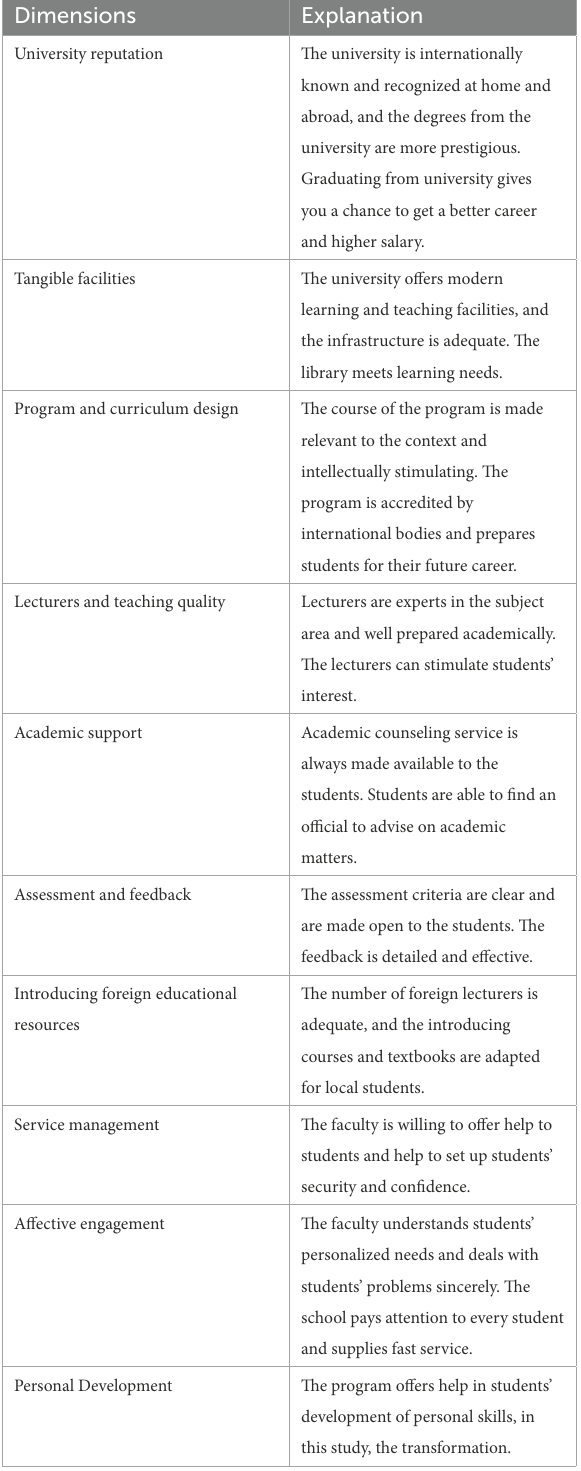
TABLE 1 Dimensions of service quality.